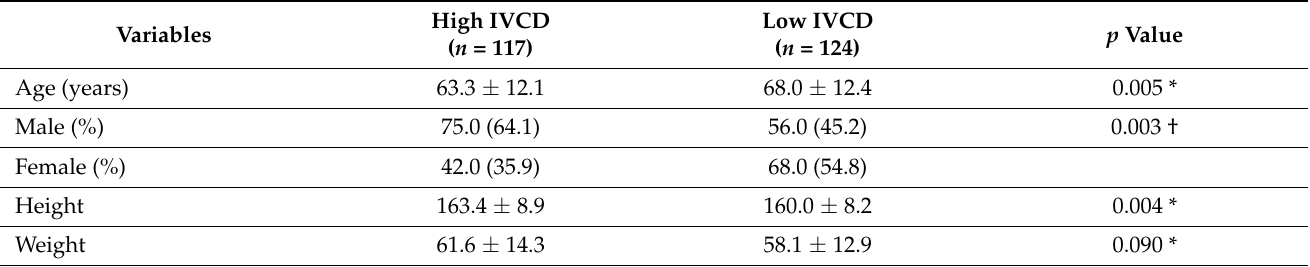
Table 1. Baseline characteristics of chronic hemodialysis (HD) patients with functional